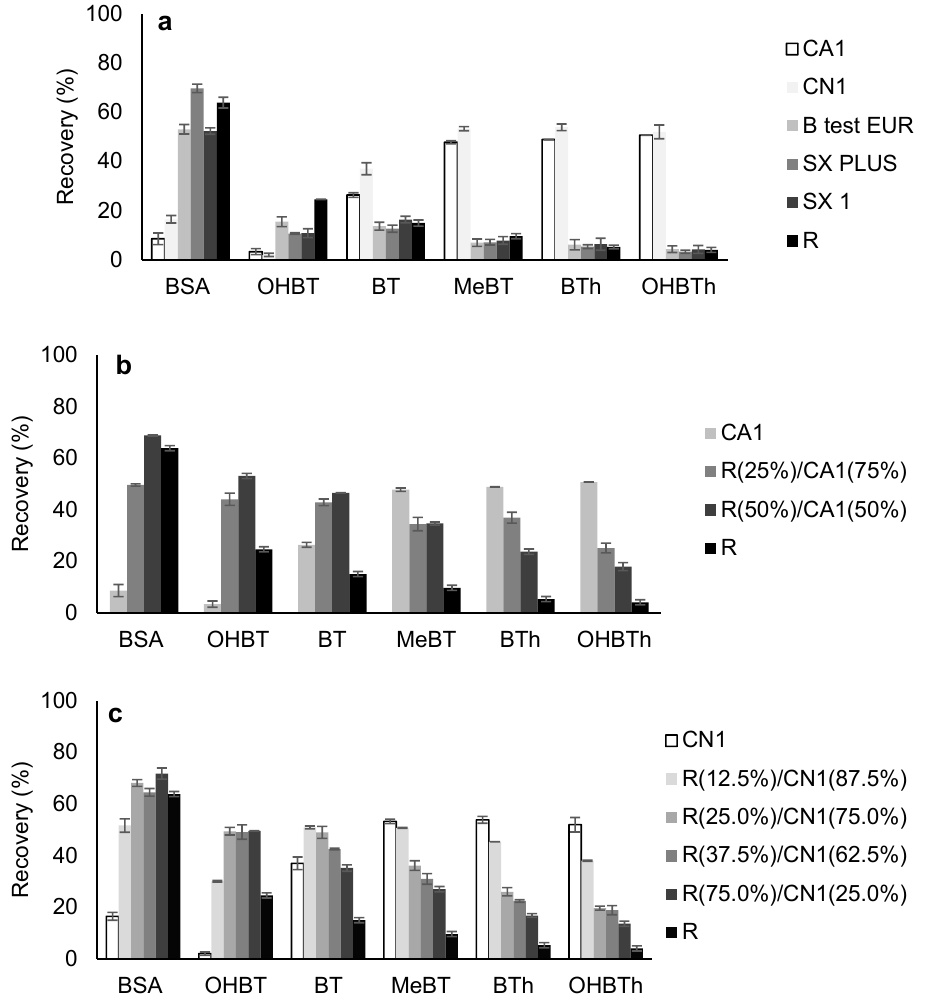
Figure 1. Effect of sorbent selectivity using neat activated carbons (ACs )( a ), R/CA1 ( b ), and R/CN1 ( c ) mixtures as coating phases for the microextraction recovery of BSA, OHBT, BT, MeBT, BTh, and OHBTh from aqueous media obtained by BA μ E- μ LD/HPLC-DAD. The error bars represent the standard deviation of three replicates.